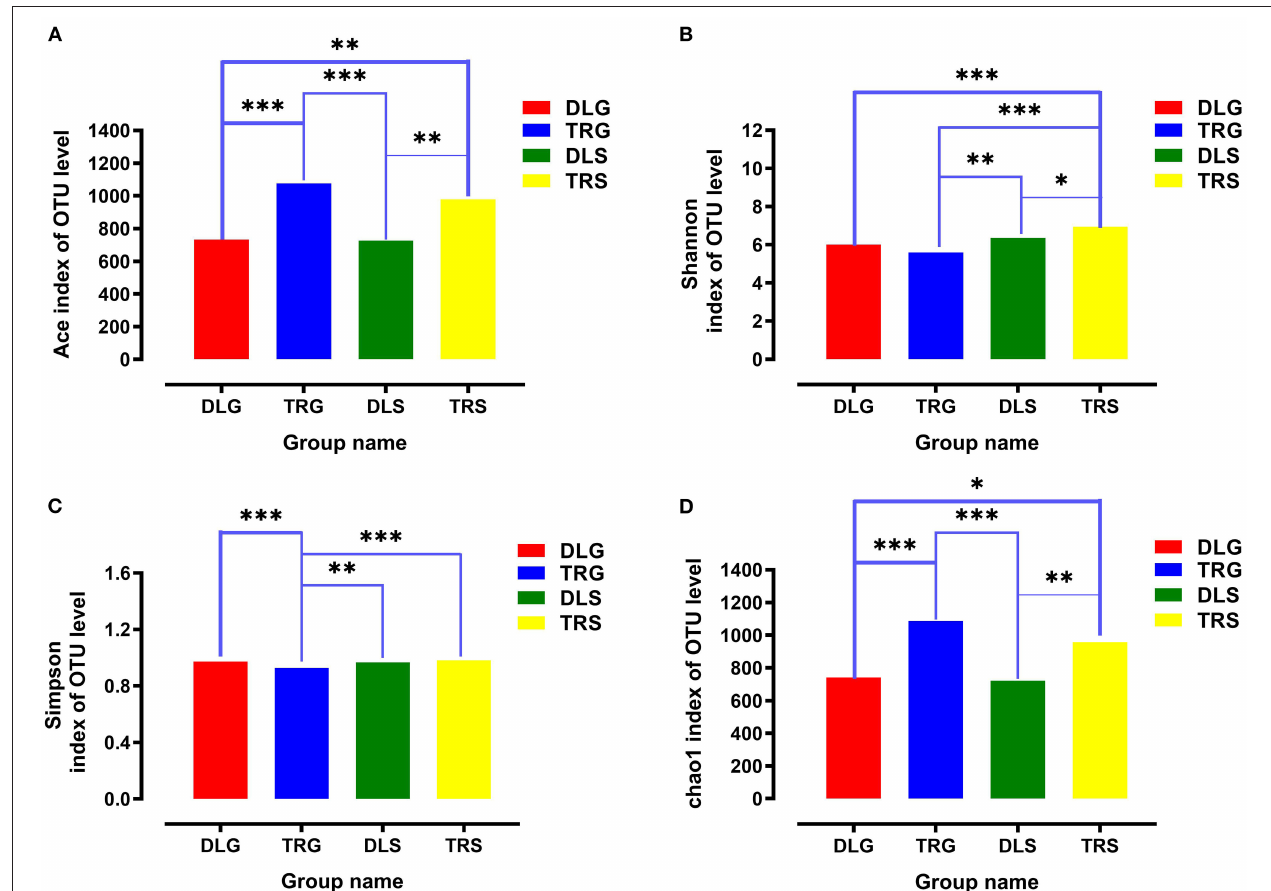
FIGURE 2 | The richness and diversities of bacterial species in the four groups. (A–D) These figures are the Ace, Shannon, Simpson, and Chao index of OTU level separately. * stands for 0.01 < P ≤ 0.05, **stands for 0.001 < P ≤ 0.01 and ***stands for P ≤ 0.001.